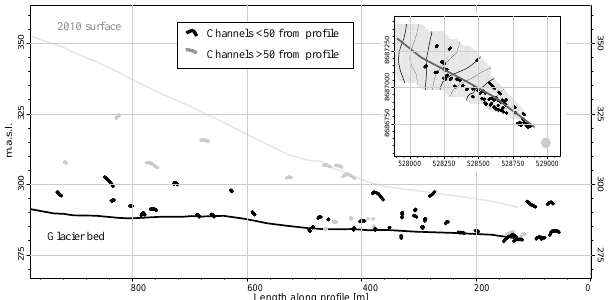
Fig. 8. Cross section of terminus with all channels identified in the 2010 lines plotted in map view (small inset) and as a function of depth and length along the profile. The channels are coloured according to distance from profile line. As the surface and bed of the glaciers changes laterally some of the channels are located above the surface and below the bed of the profile.